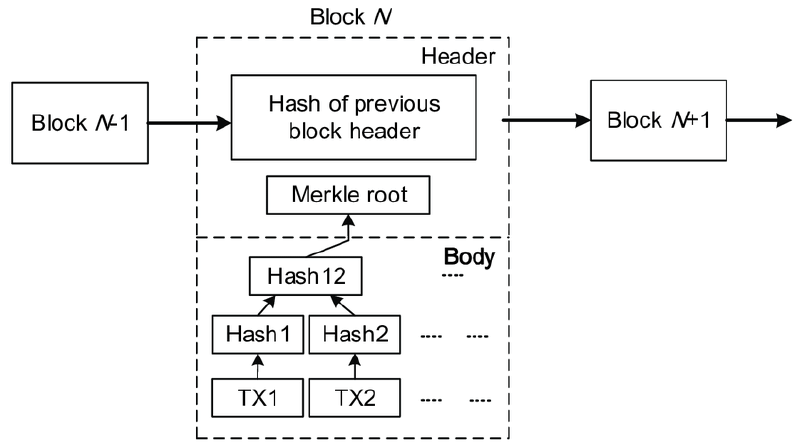
Figure 2. Blockchain structure.